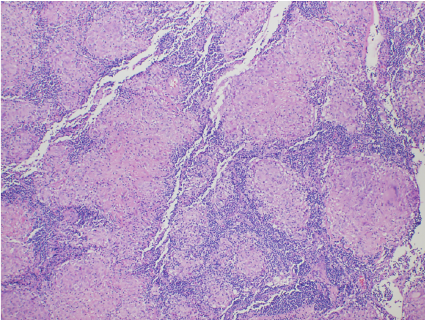
Figure 4: Right paratracheal lymph node histology; medium mag-